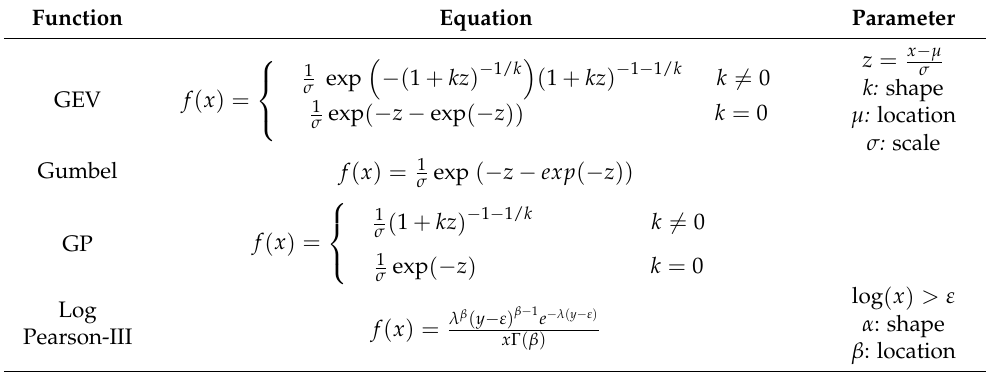
Table 2. Probability distribution functions used to fit satellite rainfall data in the present study. Function